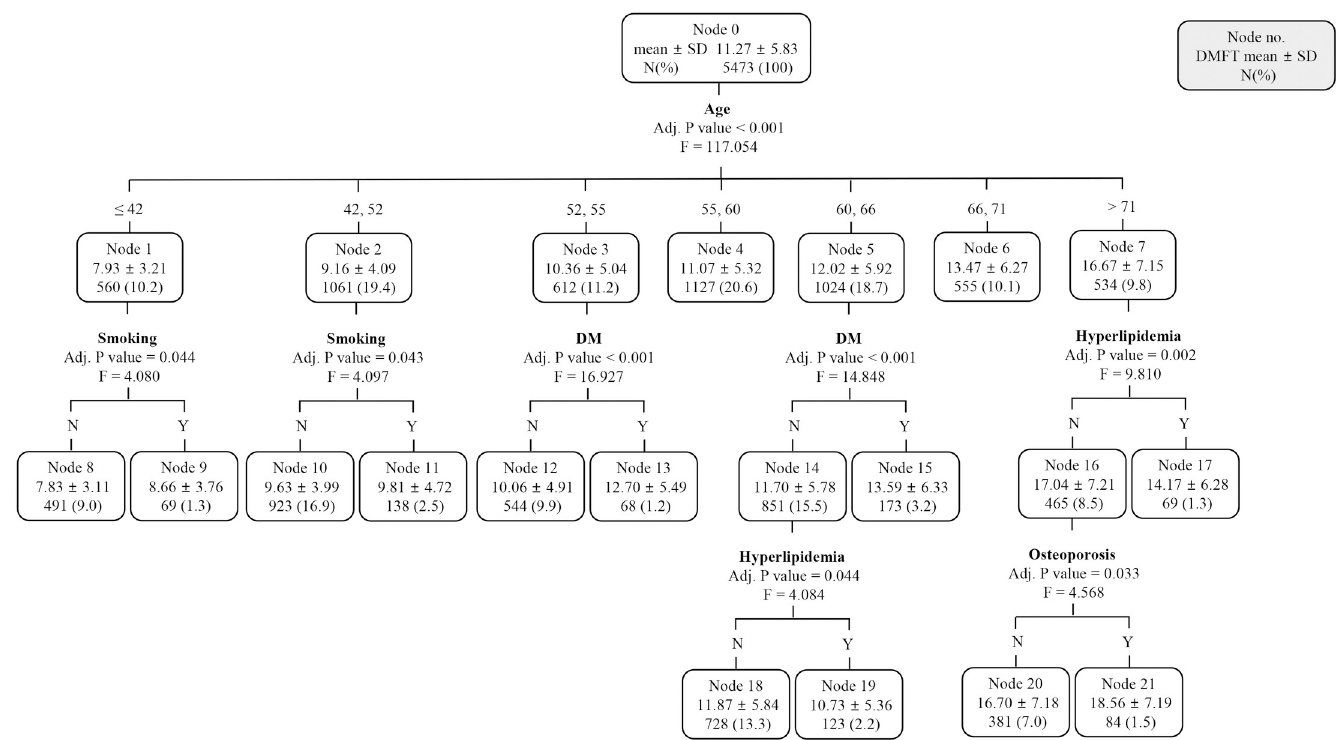
Fig 3. A chi-square automatic interaction detection classification tree analysis to identify the predictors related to the DMFT of subjects with DMFT score � 4.5. Data were presented as mean ± standard deviation. F, female; M, male; DM, diabetes mellitus.